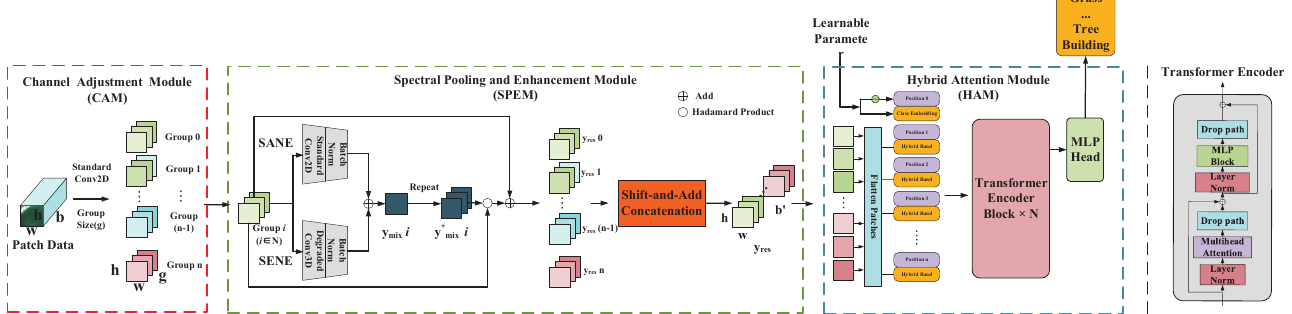
Figure 1. Overall architecture of the proposed NEHT network for HSIs classification. The NEHT network is composed of the Channel Adjustment Module (CAM) in the red rectangle, the Spectral Pooling and Enhancement Module (SPEM) in the green rectangle, and the Hybrid Attention Module (HAM) in the blue